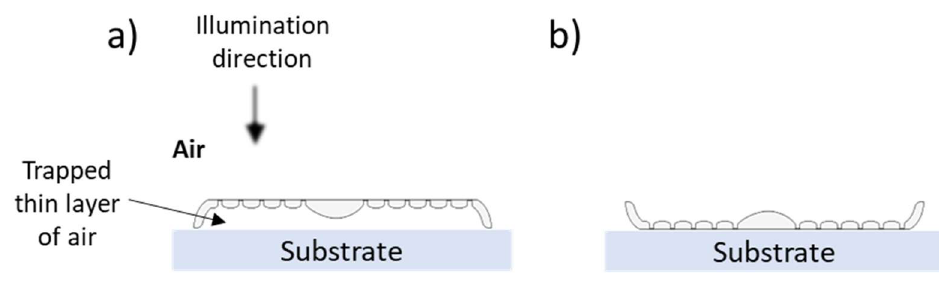
Figure 12. Schematic diagrams showing a GP valve (represented by CS long,3 ) laying on a substrate with the external ( a ) or internal face ( b ) fronting the light source.